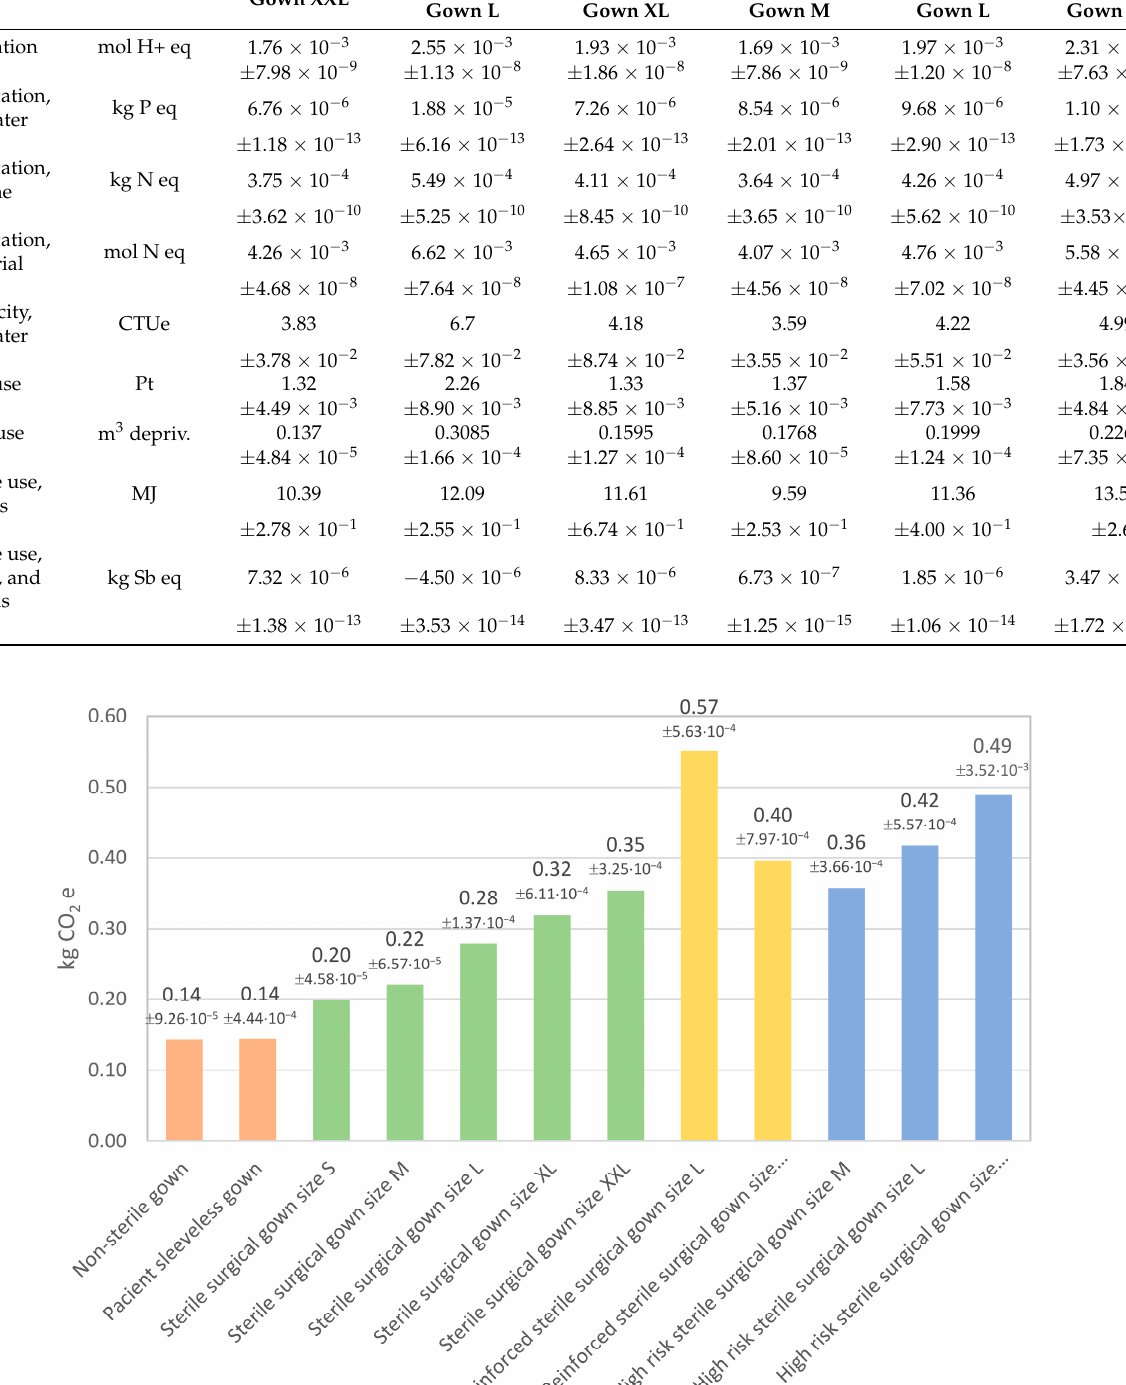
Table 5. Percentual contribution of each material to the carbon footprint of the gowns ( ≥ 2%).